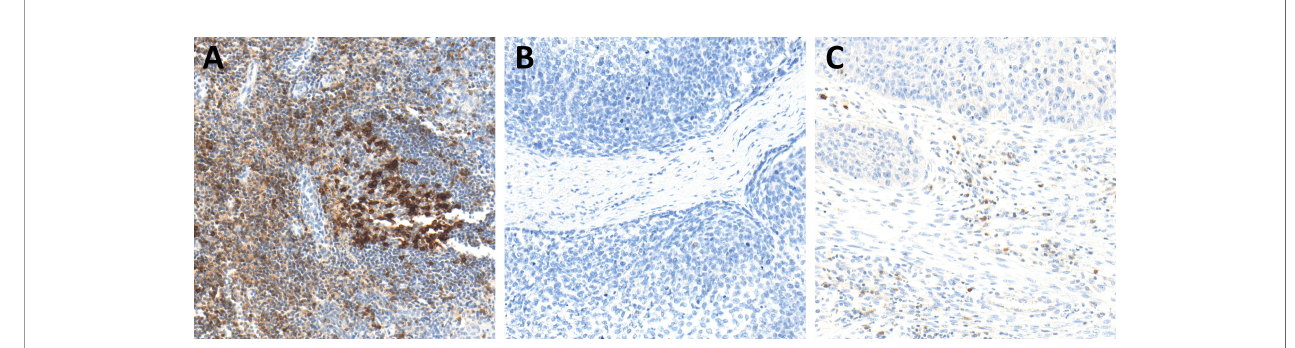
FIGURE 5 | Immunohistochemistry (IHC) of PD-1 expression in hot (A) , cold (B) , and excluded (C) head and neck squamous cell carcinomas (HNSCCs). In hot HNSCCs (A) , the expression of PD-1 was very high, while it was very low in cold (B) and excluded (C) HNSCCs.